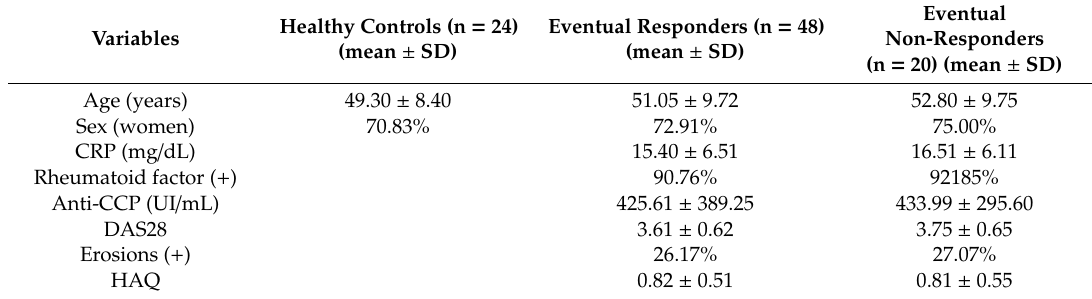
Table 1. Patient demographic, clinical and biological characteristics at